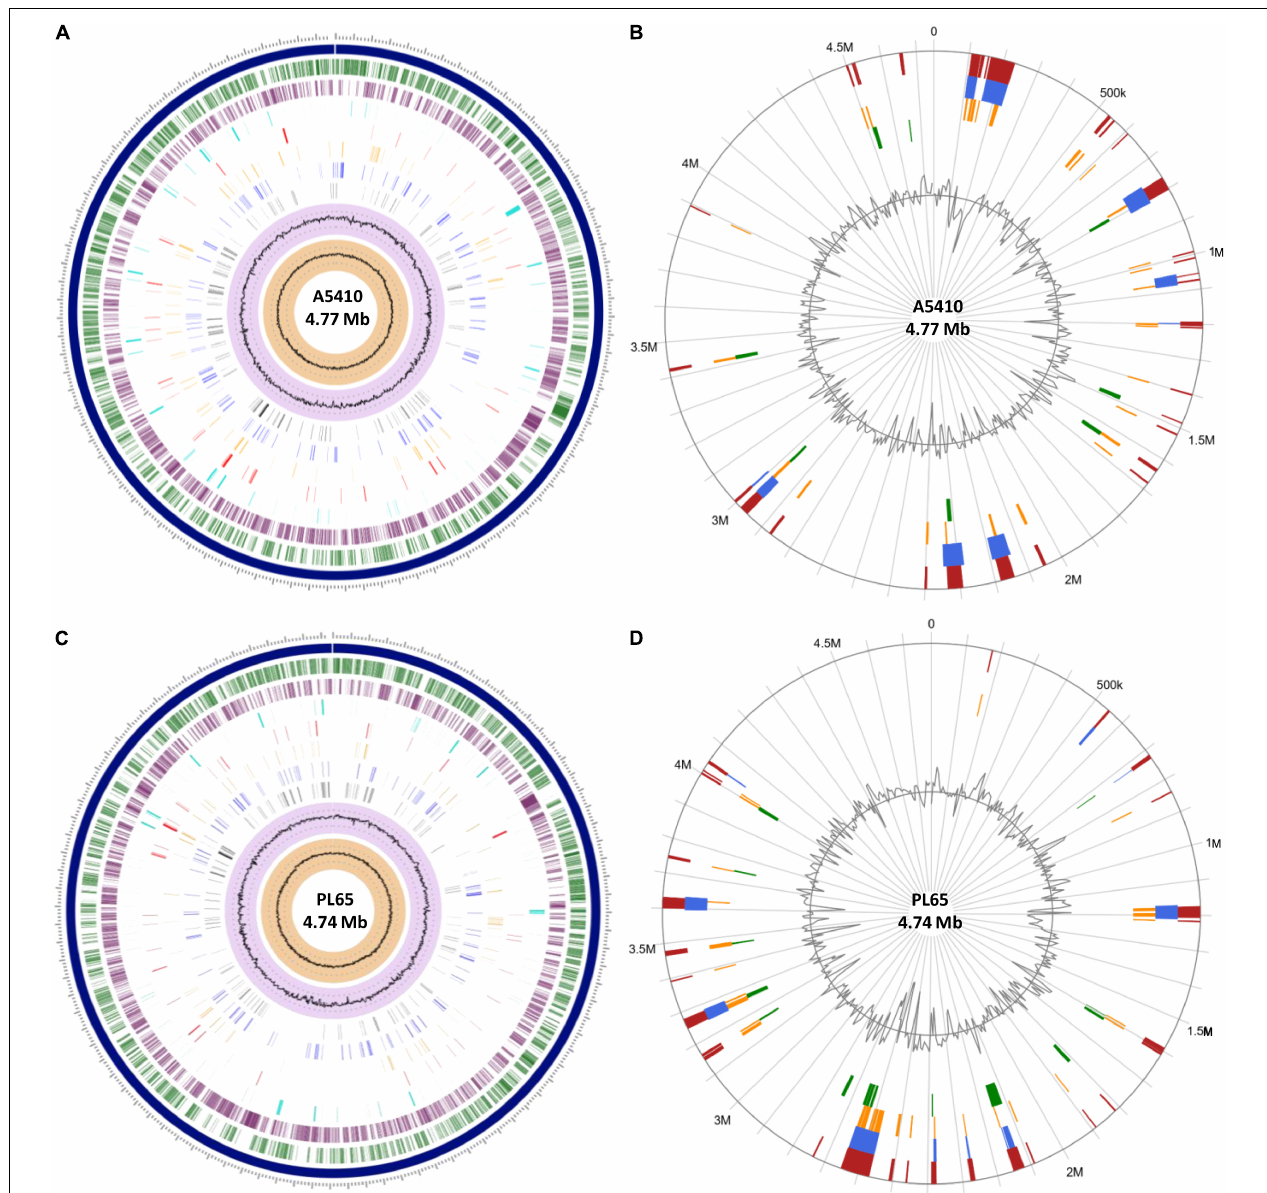
FIGURE 8 | The circular view of the genomes of (A) A5410 and (C) PL65 strains generated using Proteome Comparison tool of Pathosystems Resource Integration Center (PATRIC) showing the physical map of significant features. From outside in: position label Mb (shown in ); the order of contigs (shown in ); distribution of coding sequences in forward strands (shown in ); distribution of coding sequences in reverse strands (shown in ); distribution of non-coding elements along the chromosome (shown in ); distribution of genes involved in antibiotic resistance (shown in ); distribution of other virulence factors (shown in ); distribution of genes encoding transporter proteins (shown in ); distribution of genes encoding drug targets (shown in ); distribution of GC content (shown in ); and distribution of GC skew (shown in ). Circular visualization of the predicted Genomic Islands (GIs) on A5410 (B) and PL65 (D) strains. The analysis was conducted in IslandViewer 4. The interactive visualization of the distinct islands across the genomes is shown with blocks colored according to the predictor tool as described: IslandPick (shown in ) based on genome comparison, IslandPath-DIMOB (shown in ) based on associated GIs features such as transfer RNAs (tRNAs), transposon elements, integrases, and sequence bias, SIGI-HMM (shown in ), based on the codon usage bias with a Hidden Markov model criterion and the integrated results of the four tools (shown in ).